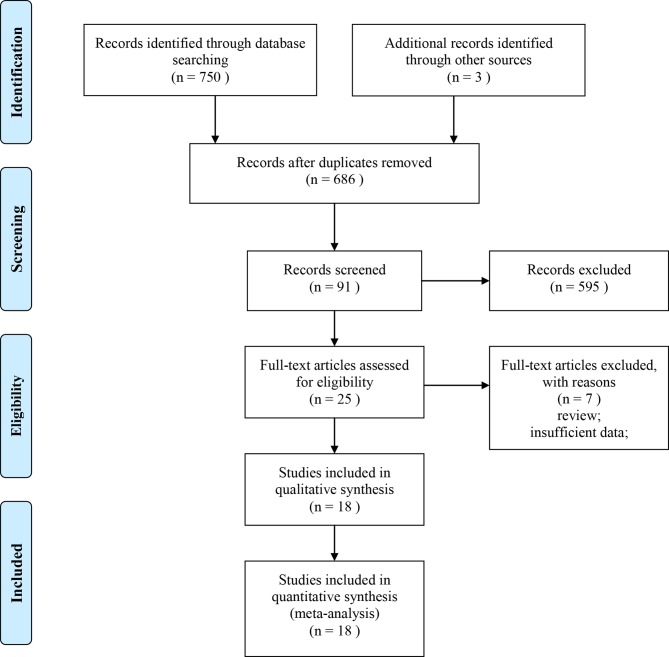
Flow diagram following the PRISMA guideline.